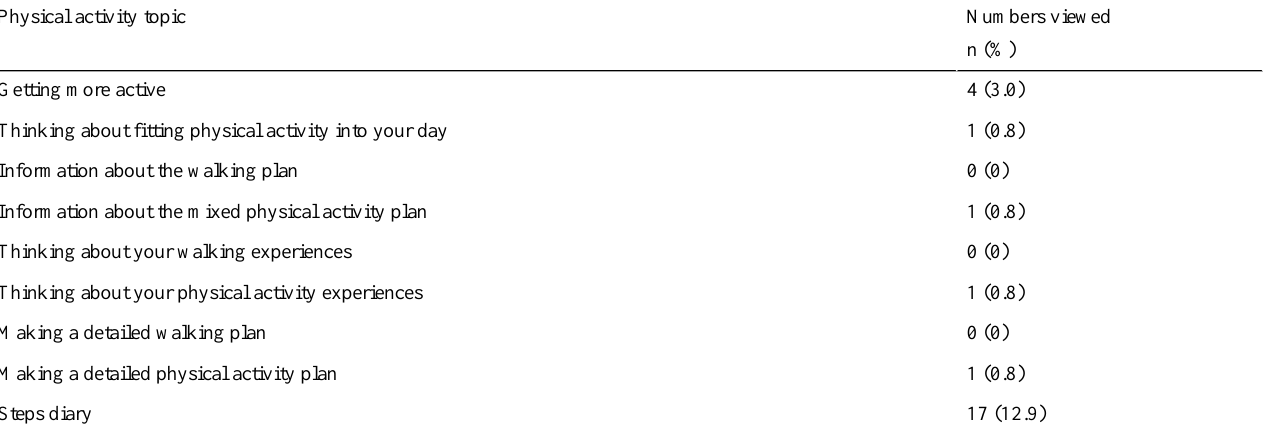
Table 7. Numbers (and percentages) of participants who used the physical activity tools.